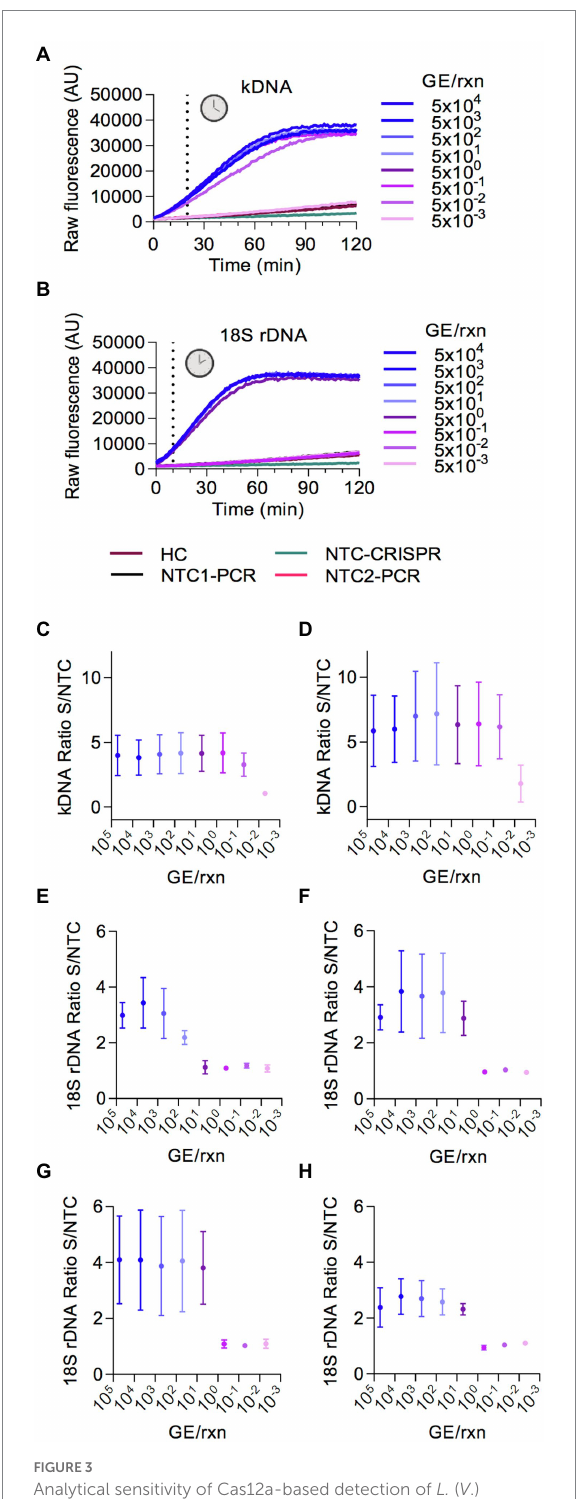
FIGURE 3 Analytical sensitivity of Cas12a-based detection of L. ( V